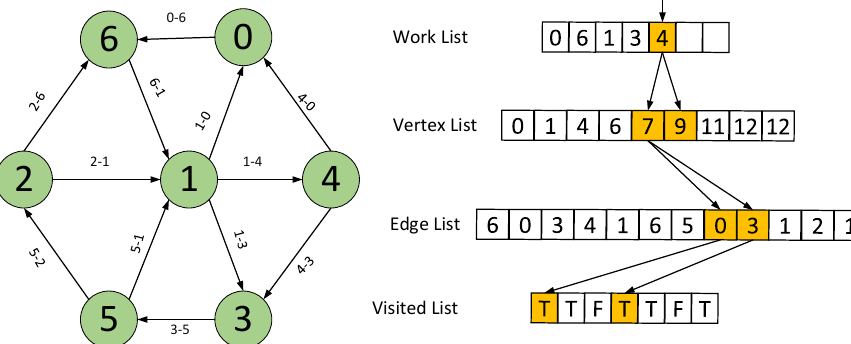
Figure 2. Compressed sparse row-based graph traversal overflow. The notation such as a − b means an edge from vertex a to vertex b . Part of the timeline for traversing this sample graph is compared between using conventional memory and CGAcc in the following